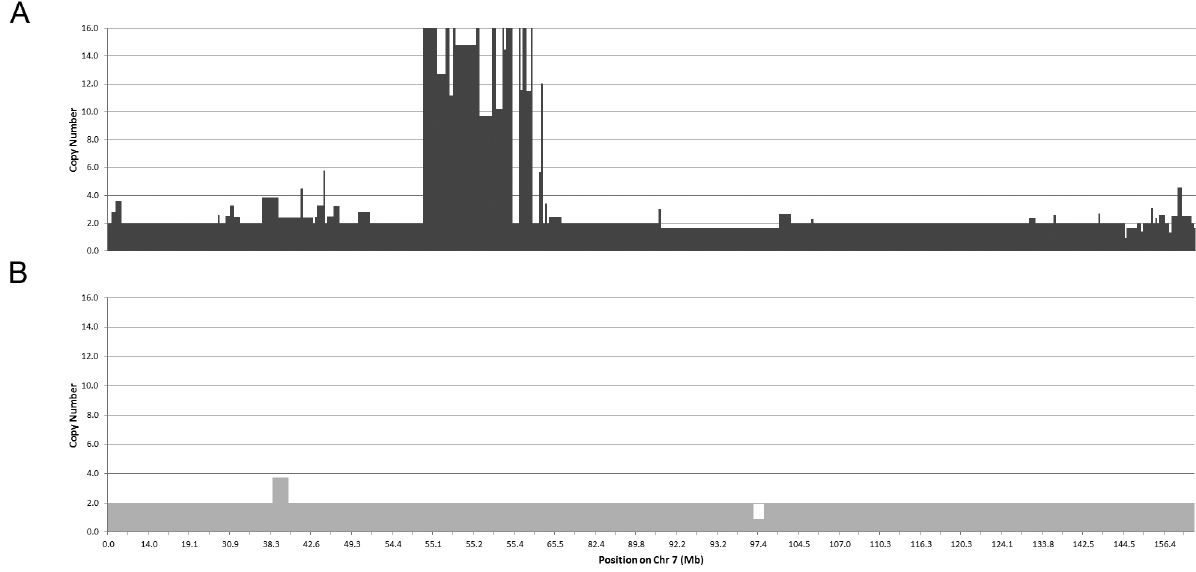
Figure 3. Schematic Illustration of Copy Number Abnormalities in Two Tumors Representing High and Low CNA Count and a Spectrum of Genomic Complexity. For both A and B, the horizontal axis represents position of segments along chromosome 7 (in Mb) and the vertical axis represents estimated copy number (truncated at 16). (A) Tumor 2515 (dark grey) has a large number of independent CNAs on chromosome 7 (N=56), including a complex copy number gains at , 55 Mb (region of EGFR) as well as other gains and losses throughout the chromosome. (B) By contrast, tumor 2634 (light grey) has few independent copy number changes (N=2, gain at , 39 Mb and loss at , 97.4 Mb). For this illustration, copy numbers in the normal range of 1.7–2.3 were assigned a value of 2.